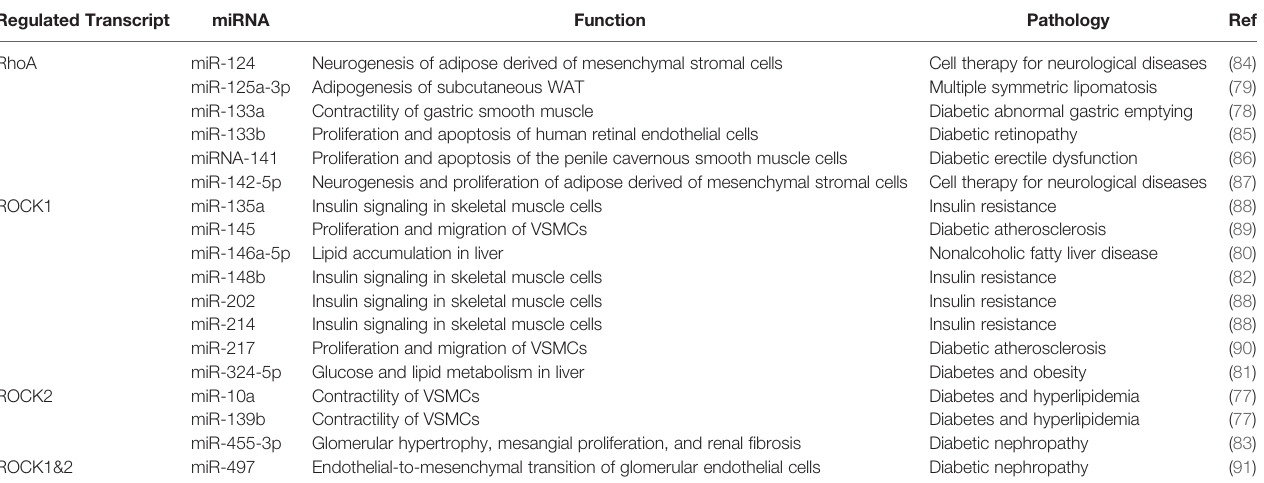
TABLE 1 | Down - regulation of RhoA, ROCK1 and ROCK2 by miRNAs in metabolic tissues. Regulated Transcript miRNA